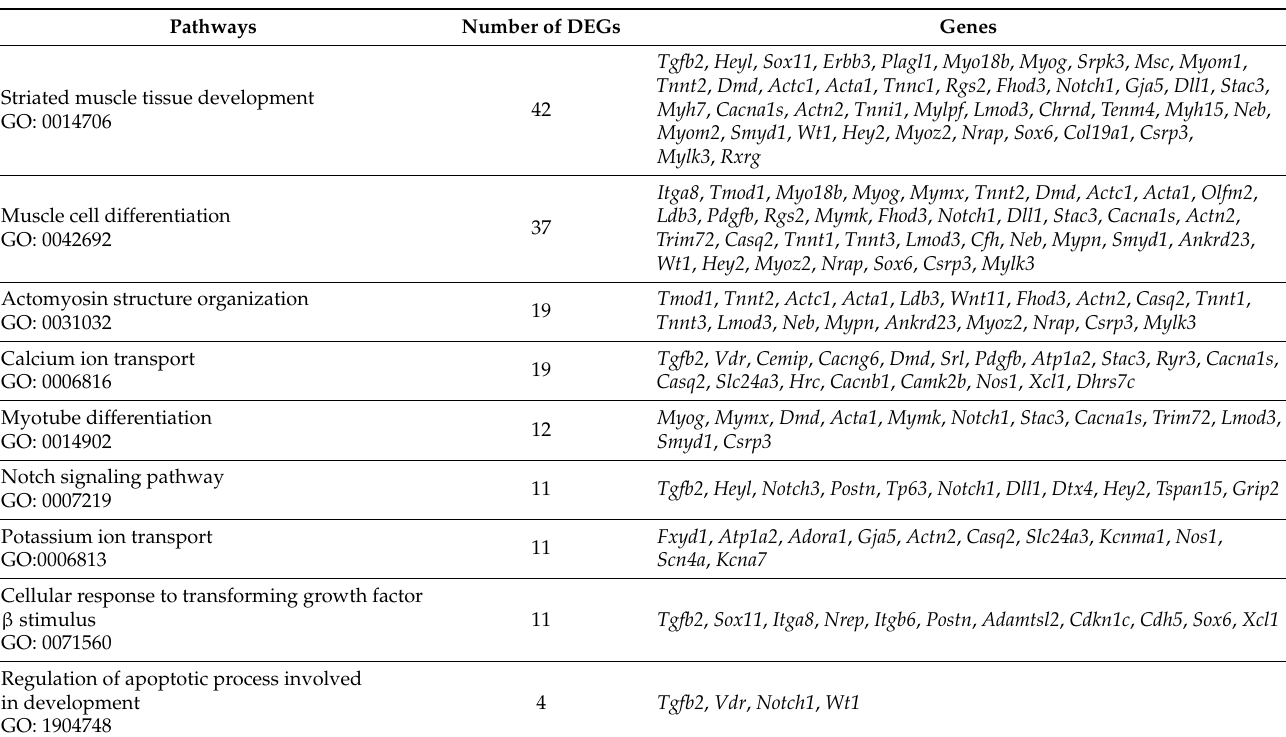
Table 2. Pathways associated with the DEGs upregulated in HS7 vs. CONTR ( p <